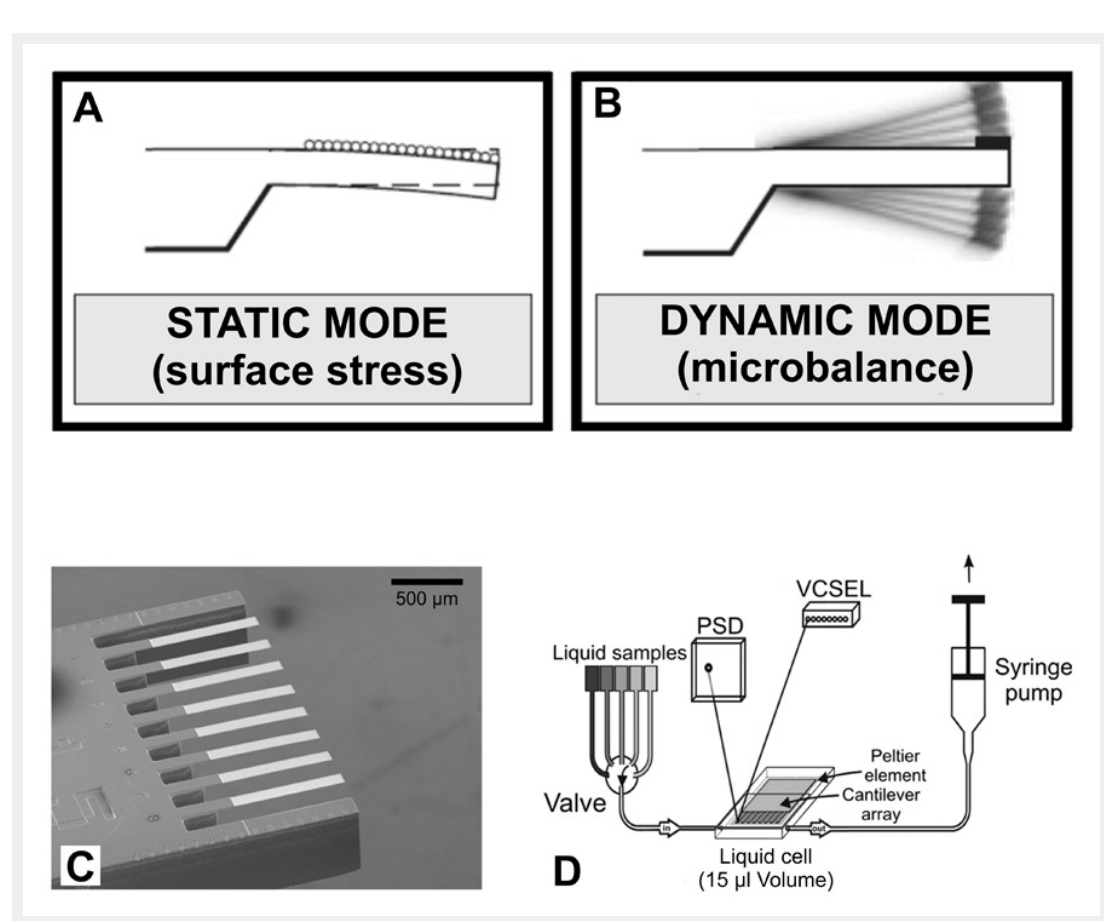
Two frequently used modes of cantilever sensor operation. The first one (A) shows the static mode where surface stress results in cantilever bending. The second mode (B) shows the operation in dynamic mode. Here the cantilever is actuated and vibrates at its specific resonance frequency. Upon binding of a ligand to the surface the resonance frequency changes and the adsorbed mass can be calculated from that shift. The two modes can also be used simultaneously. (C) Shows an electron microscope image of an array with eight 750 µm long cantilevers. (D) Illustrates the liquid handling system and the beam deflection read out of a cantilever setup. A total of 8 Vertical Cavity Surface Emitting Lasers (VCSEL) are used to sequentially determine cantilever deflections. The laser beam is deflected at the end of the cantilevers to a Position Sensitive Detector (PSD). Below the cantilever array is a peltier element which produces a heat pulse to test the mechanical properties of the cantilevers. Syringe pump and multi valve systems allow a constant flow of samples to the cantilever measurement